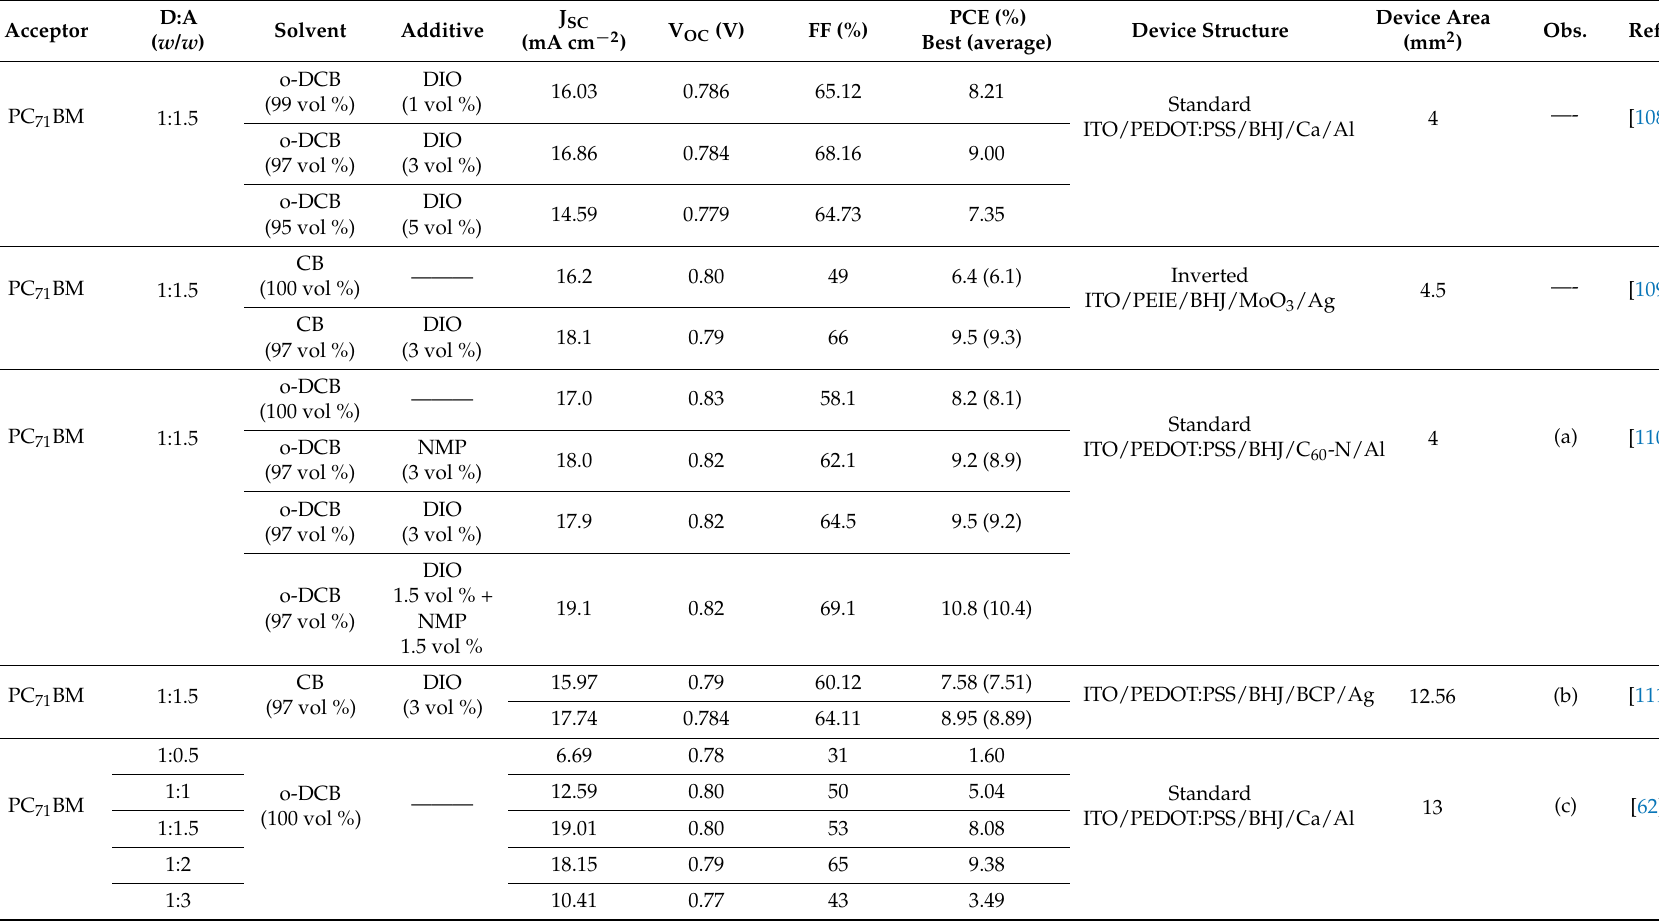
Table 2. Summary of the most relevant device figures of merit and efficiency results obtained with PTB7-Th:fullerene